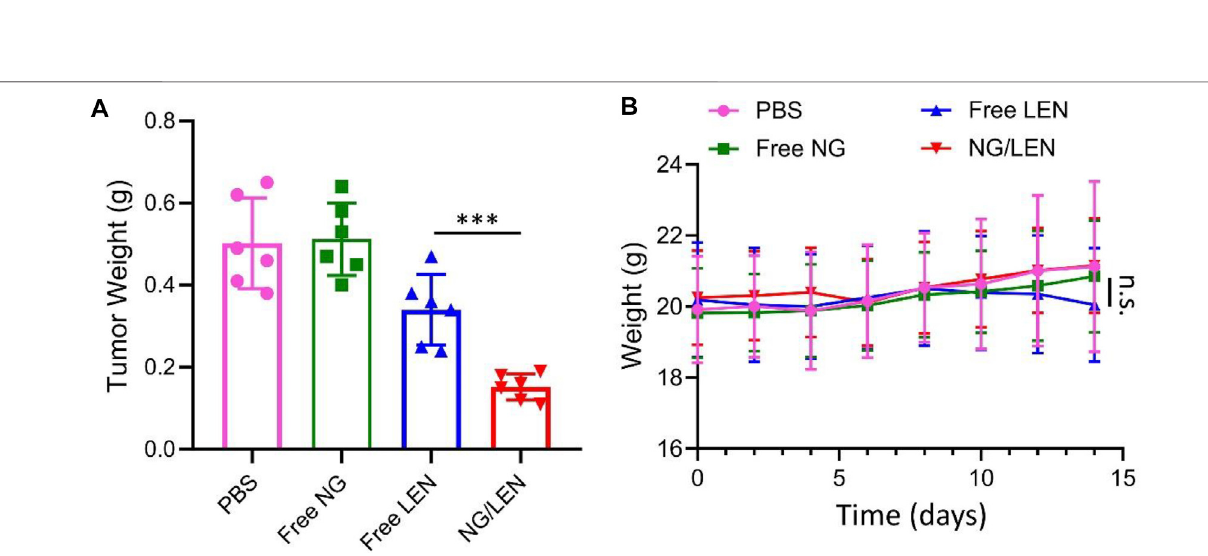
Frontiers in Pharmacology |